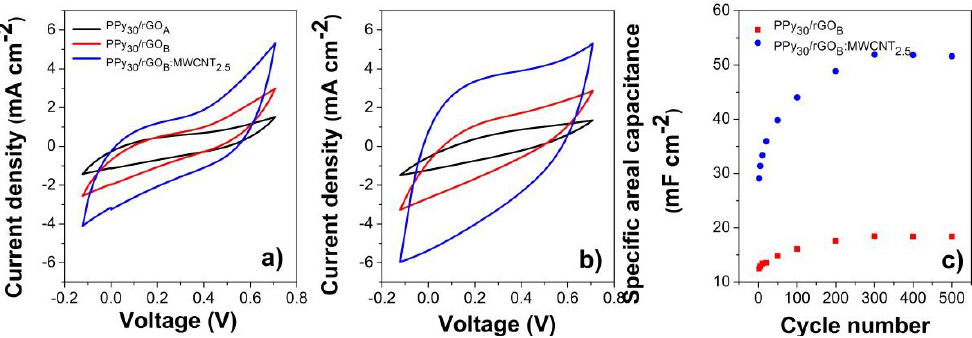
Figure 7. Evolution of CV (V vs. Ag/AgCl) curves of PPy 30 /rGO A , PPy 30 /rGO B and PPy 30 /rGO B :CNT 2.5 with cycling at 50 mV s −1 : First cycle ( a ), 500th cycle ( b ) and areal capacitance as function of cycle number ( c ).